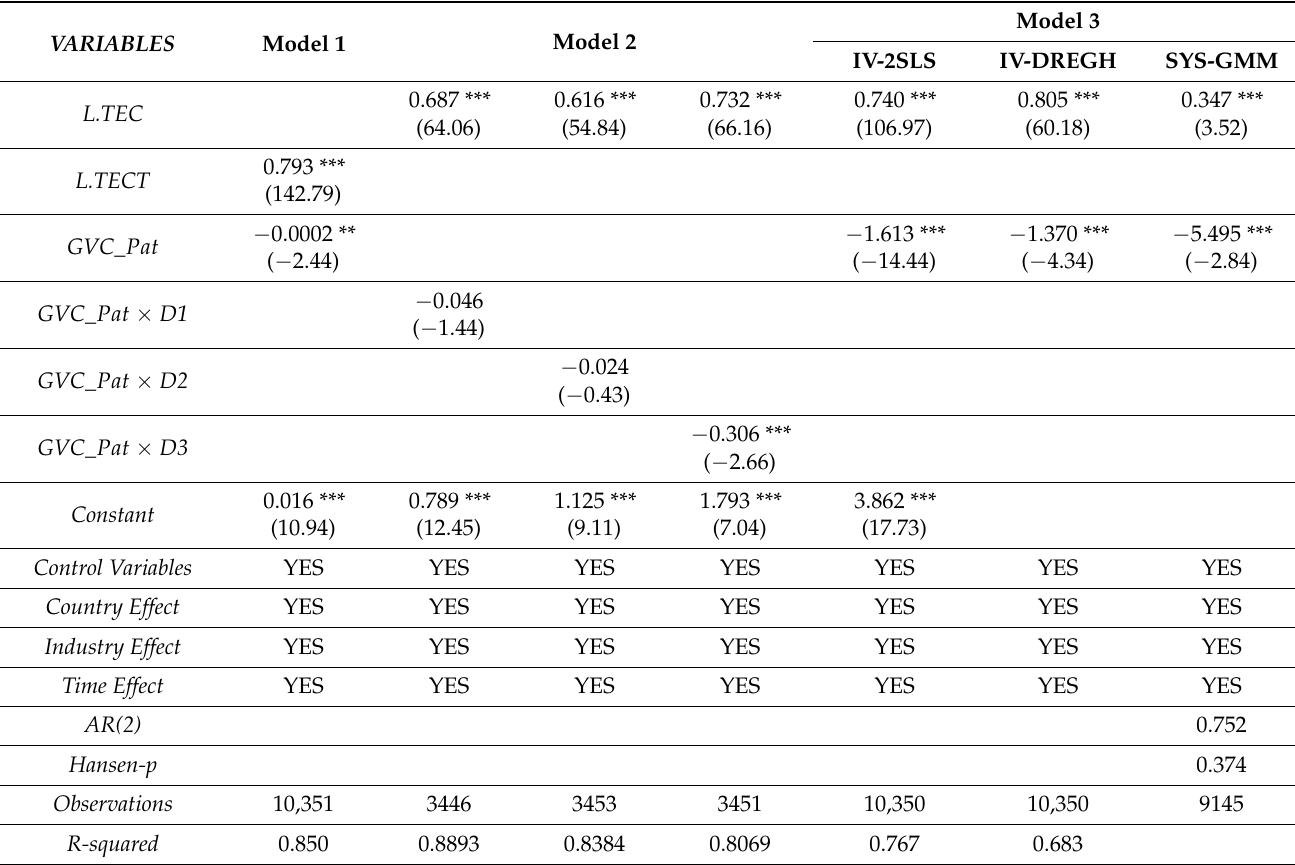
Table 4. Robustness test